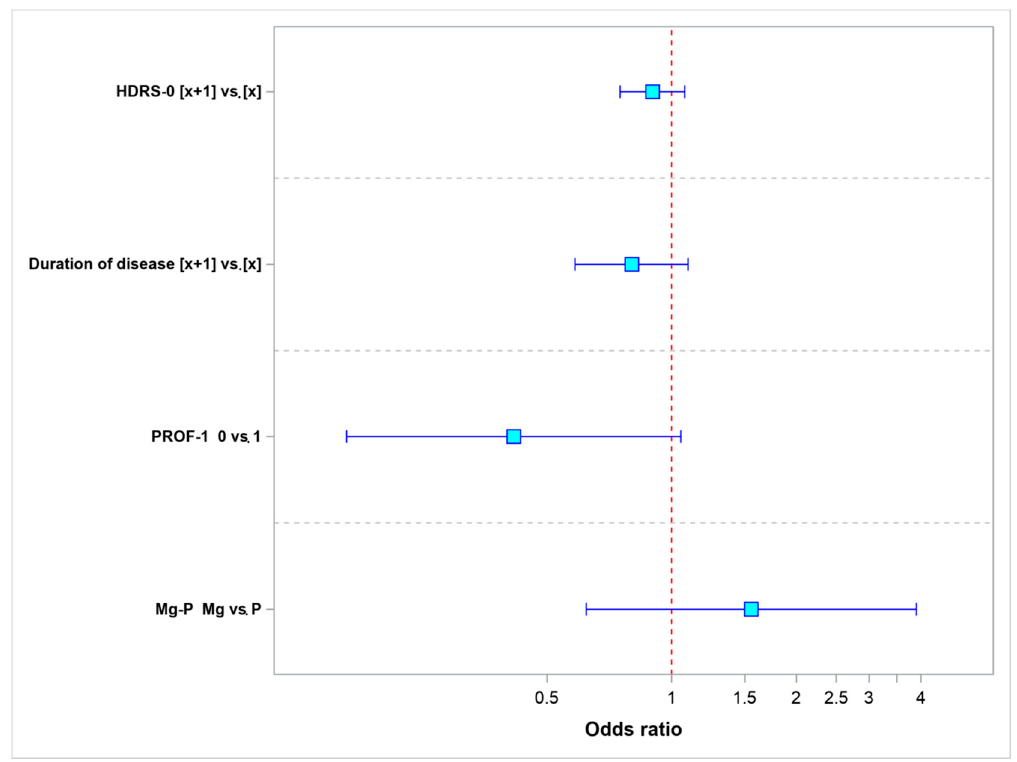
Figure 3. Odds ratio values for remission.